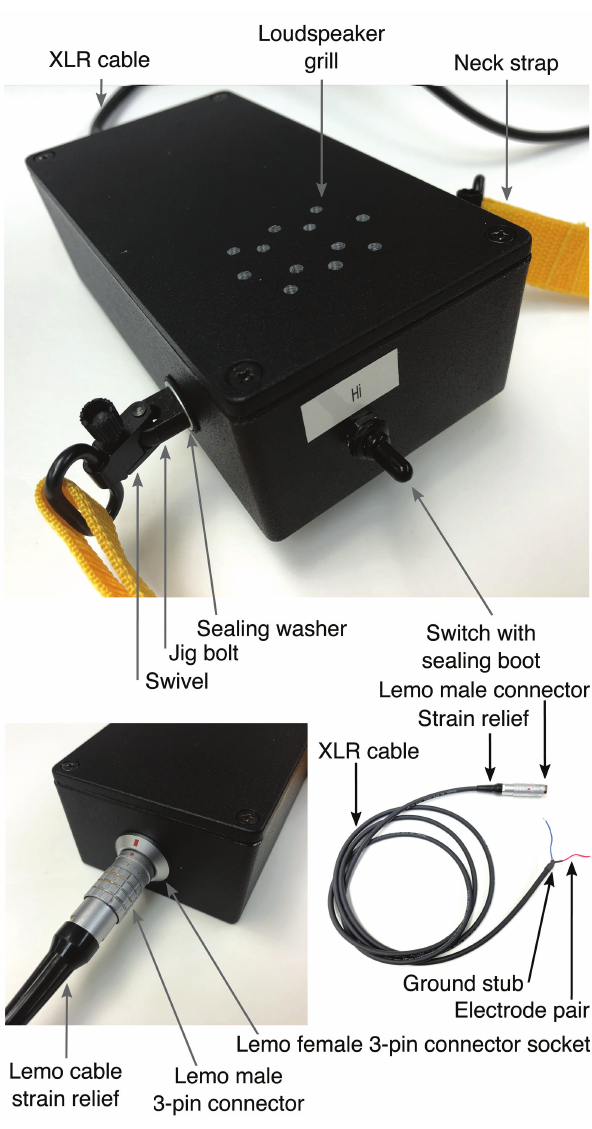
Fig. 4. External view of electric fish finder (above, bottom left) and electrode cable/connector assembly (bottom